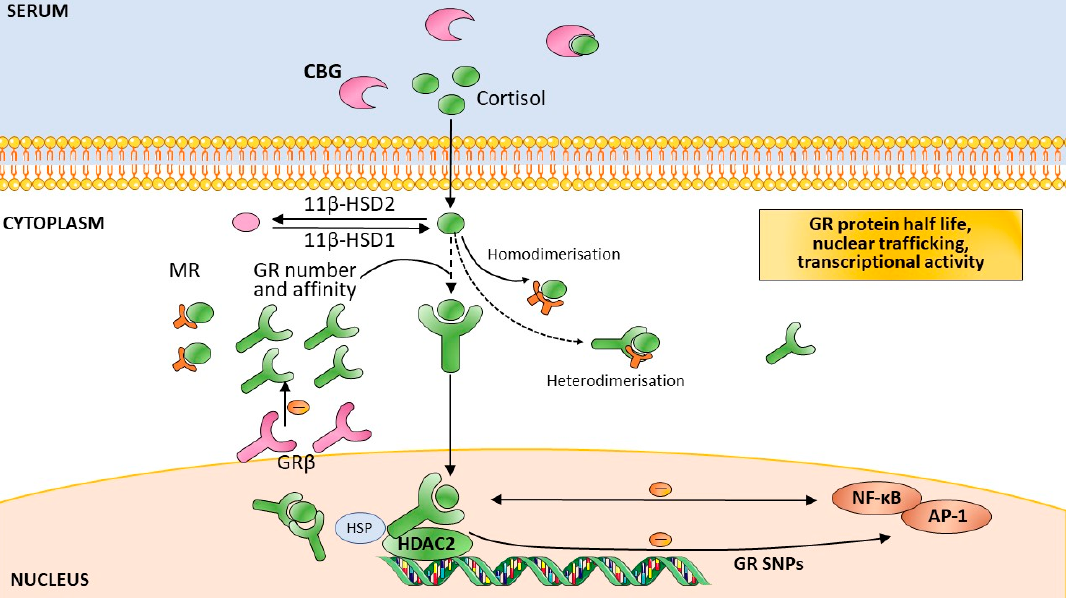
Figure 1. Modulators of the cellular action of glucocorticoids. These modulators include glucocorticoid availability, glucocorticoid receptor number and affinity, GR β isoform expression, glucocorticoid receptor signalling, mineralocorticoid receptor signalling, glucocorticoid receptor–gene interaction, and glucocorticoid receptor single nucleotide polymorphisms. Abbreviations: 11 β -HSD: 11- β -hydroxysteroiddehydrogenase; CBG:Corticosteroid-bindingglobulin; GR:glucocorticoidreceptor; HSP: heat shock protein; MR: mineralocorticoid receptor; NF- κ B: nuclear factor k B; SNPs: single nucleotide polymorphisms; HDAC2: histone deacetylase 2; AP-1: activator protein 1. Adapted by permission from [Nature]